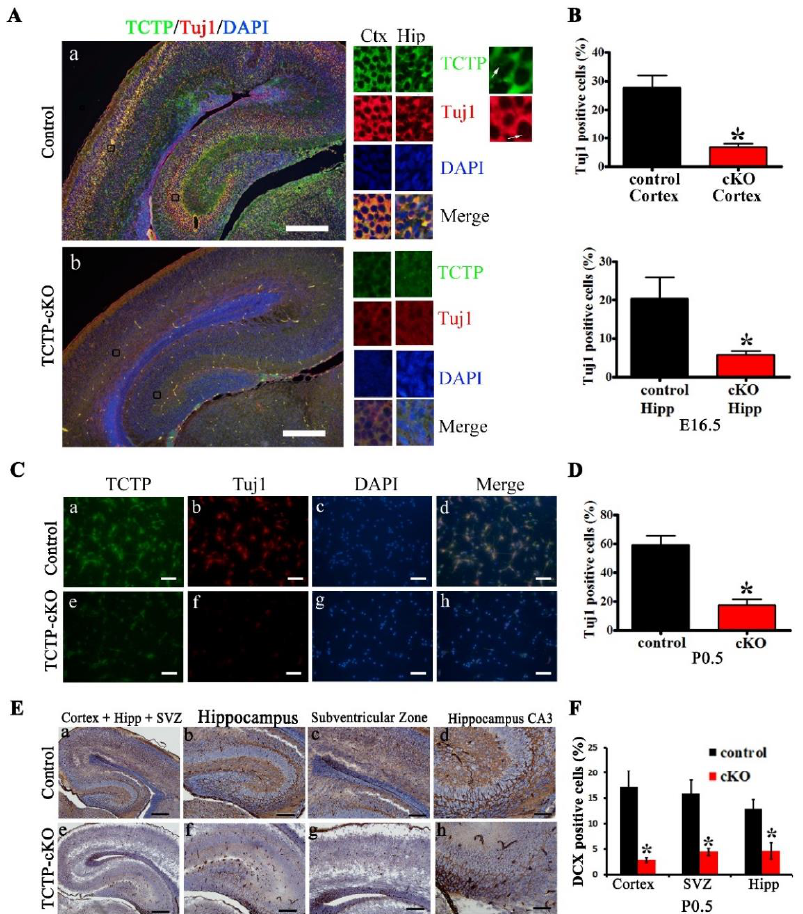
Figure 5. Central nervous system (CNS) neurogenesis of TCTP-cKO and control mice was detected. ( A ) Double immunofluorescence staining detected TCTP (green) and Tuj1 (red) of brain sections at E16.5. Bottom panel shows magnification of panels a and b. ( B ) Bar graph summarizing the quantification of Tuj1-positive cells in ( A ). ( C ) TCTP (green) and Tuj1 (red) of primary cultured cortical neurons from control and TCTP-cKO mice at P0.5 were detected. ( D ) Bar graph summarizing the quantification of Tuj1-positive cells in ( C ). ( E ) The neurogenesis marker doublecortin (DCX) was detected in TCTP mutant brains from control and TCTP-cKO mice at P0.5. ( F ) Bar graph summarizing the quantification of DCX-positive cells in ( E ). (Data presented as mean ± SEM, * p < 0.05, Student’s t test, n = 3 per group.) Scale bars: A, 200 µ m, B, 40 µ m, C, a, e, 200 µ m; b–d, f–h, 100 µ m. A representative picture